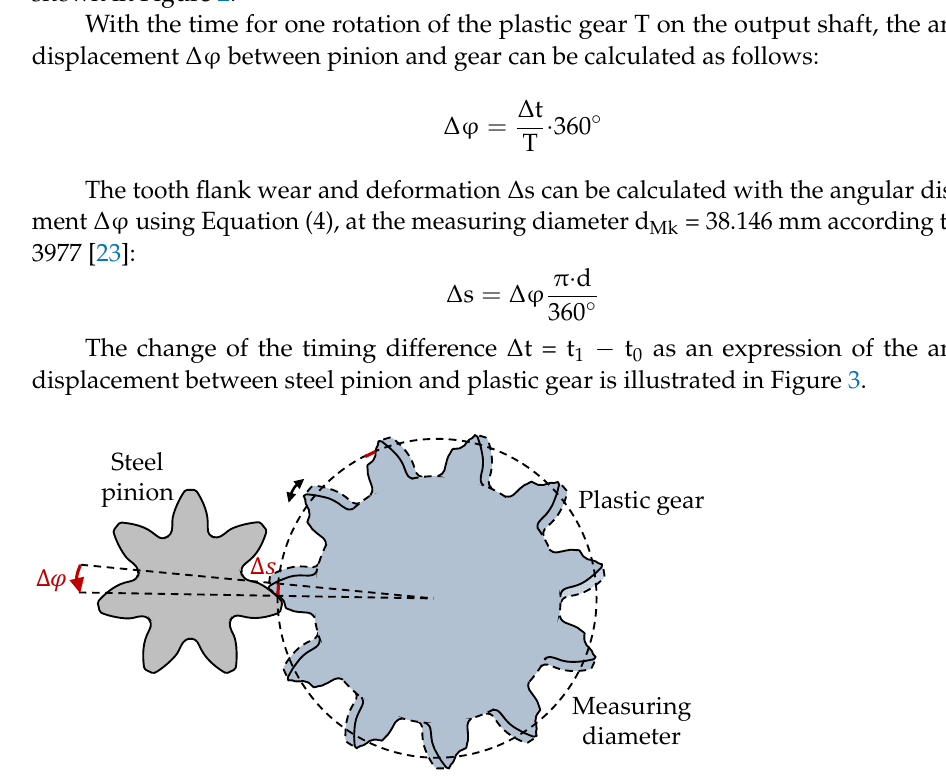
Figure 3. Wear and deformation induced angular displacement of pinion and gear, reprinted from Ref. [22].